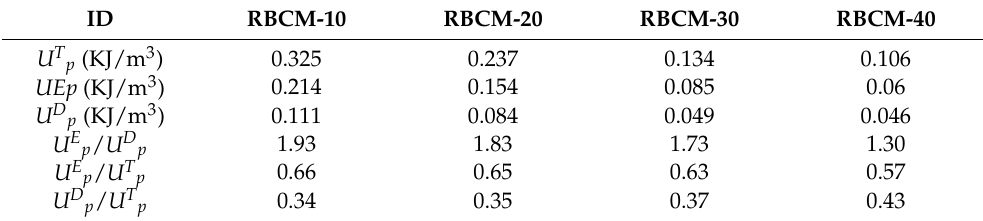
Table 2. The U T p , U E p , and U D p of the RBCM at the peak stress point.